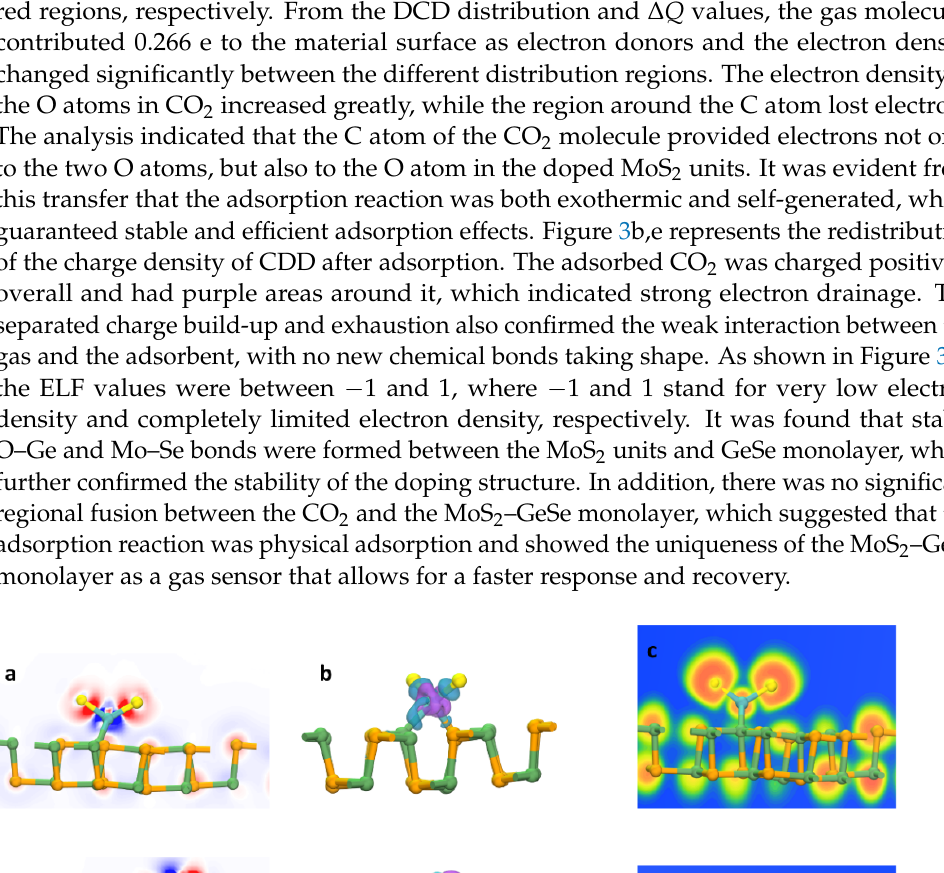
Figure 2. The TDOS and PDOS analyses of the CO 2 /MoS 2 –GeSe monolayer. The Fermi level is set at zero. ( a ) TDOS of CO 2 /MoS 2 –GeSe monolayer. ( b ) PDOS of CO 2 /MoS 2 –GeSe monolayer. ( c ) PDOS of two CO 2 . ( d ) PDOS of CO 2 /MoS 2 –GeSe monolayer with atoms.